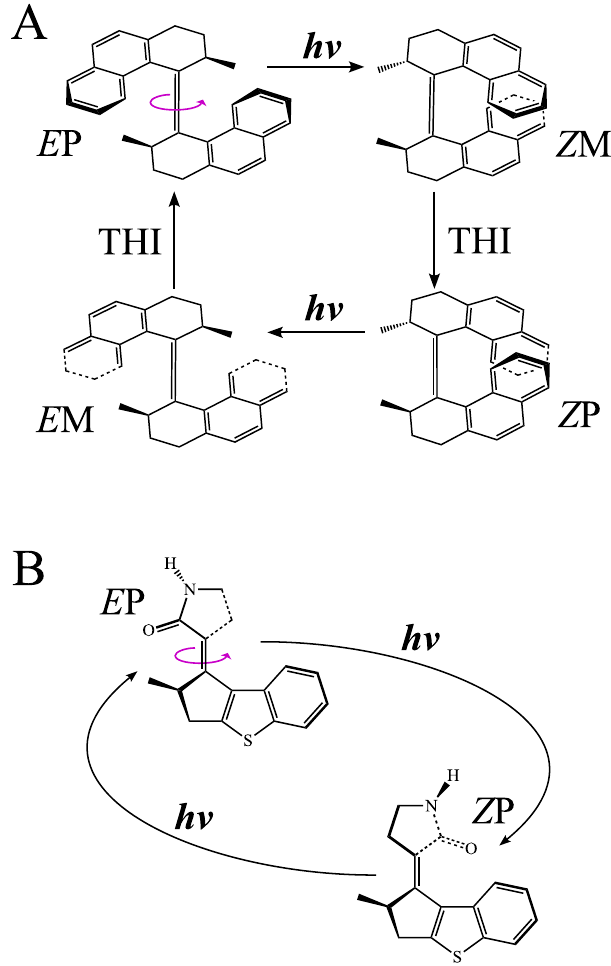
Fig.3|Rotarycycle(alsoworkingcycleorphotochemicalcycle).A Rotarycycle of a classic 4-stroke LDRM ofFig.1. B Hypotheticalrotary cycleofa 2-strokeLDRM proposed here.Thetwosequentiallyabsorbedphotonsare,ingeneral,ofdifferent